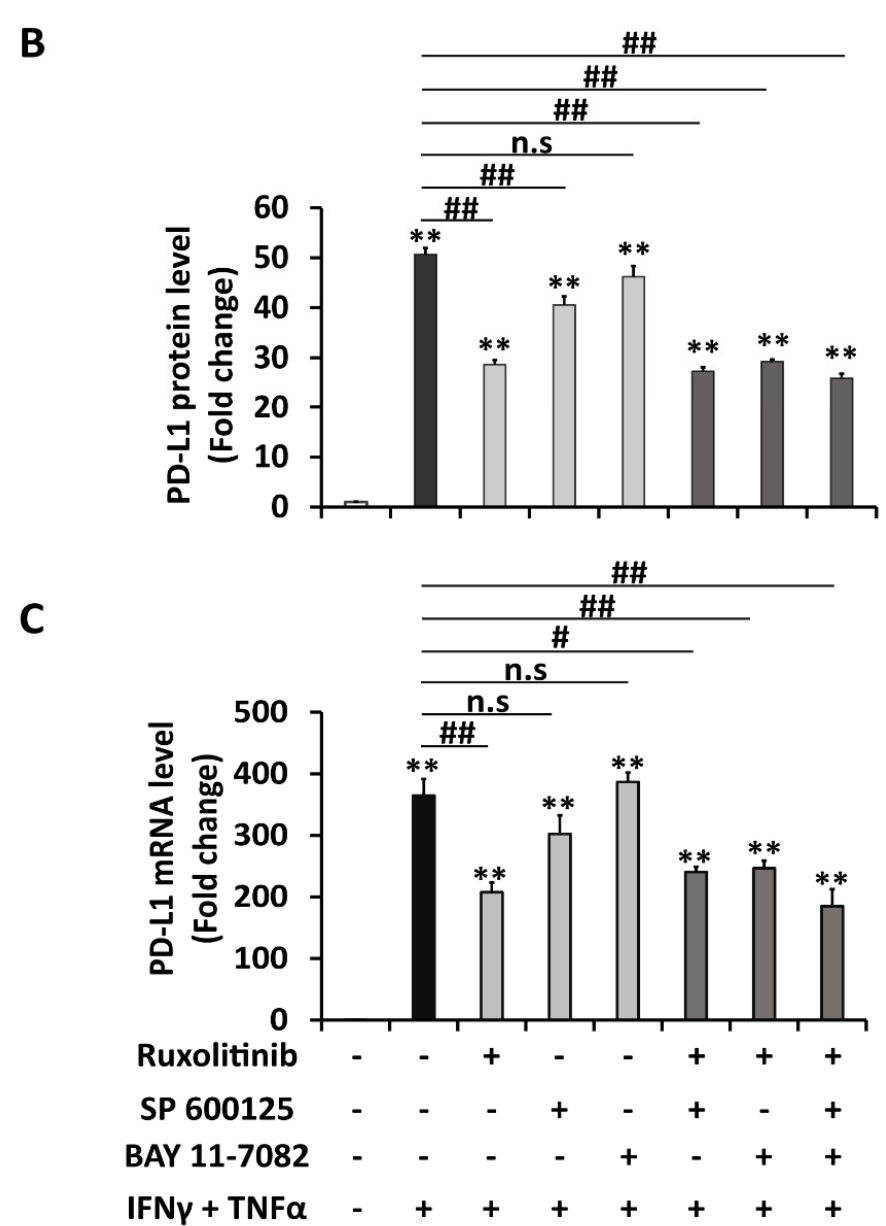
Figure 4. Enhanced upregulation of PD-L1 expression by combination treatment of IFN γ and TNF α compared to individual cytokine treatment is mainly dependent on STAT-1 signaling pathway. ( A – C ) Analysis of PD-L1 expression of HepG2 cells pre-treated for 2 h with individual or combination of inhibitors: JAK inhibitor (ruxolitinib 1 µ M), JNK inhibitor (SP 600125 10 µ M), NF- κ B inhibitor (BAY 11-7082), which was followed by treatment with a combination of IFN γ 1 ng/mL and TNF α 10 ng/mL for 6 h in RT- PCR analysis, and for 24 h in Western blot analysis. ( A , B ) Western blot analysis and quantification. β -actin was used as a loading control. ( C ) RT-PCR analysis. Relative PD-L1 mRNA level was normalized to the expression of the GAPDH gene. Data are presented as mean ± SD. n = 3. * p < 0.05, ** p < 0.01 compared to control. # p < 0.05, ## p < 0.01 compared to IFN γ and TNF α combined